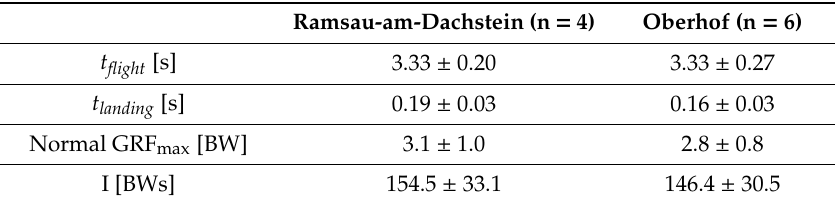
Table 1. Average ± SD of t flight , t landing , normal GRF max , and I of 3 jumps of 10 athletes (n = 10) who performed on the ski jumping hills of Ramsau-am-Dachstein and Oberhof.